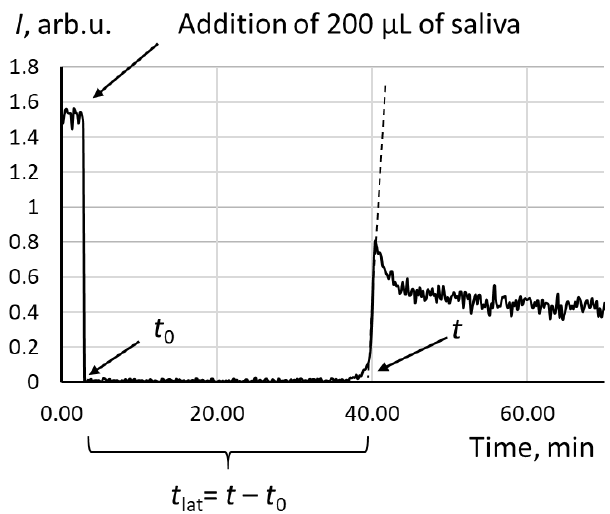
Figure 4. The chemiluminogram of a saliva sample of a healthy volunteer; the system contains ABAP (2.5 mM), luminol (2 µM), and saliva (200 µL); the latency time t lat was used as an analytical signal. Table 3. Temperature program (temperature and duration in seconds of the stage) for atomic absorption analysis including drying, charring, atomization, and cleaning.